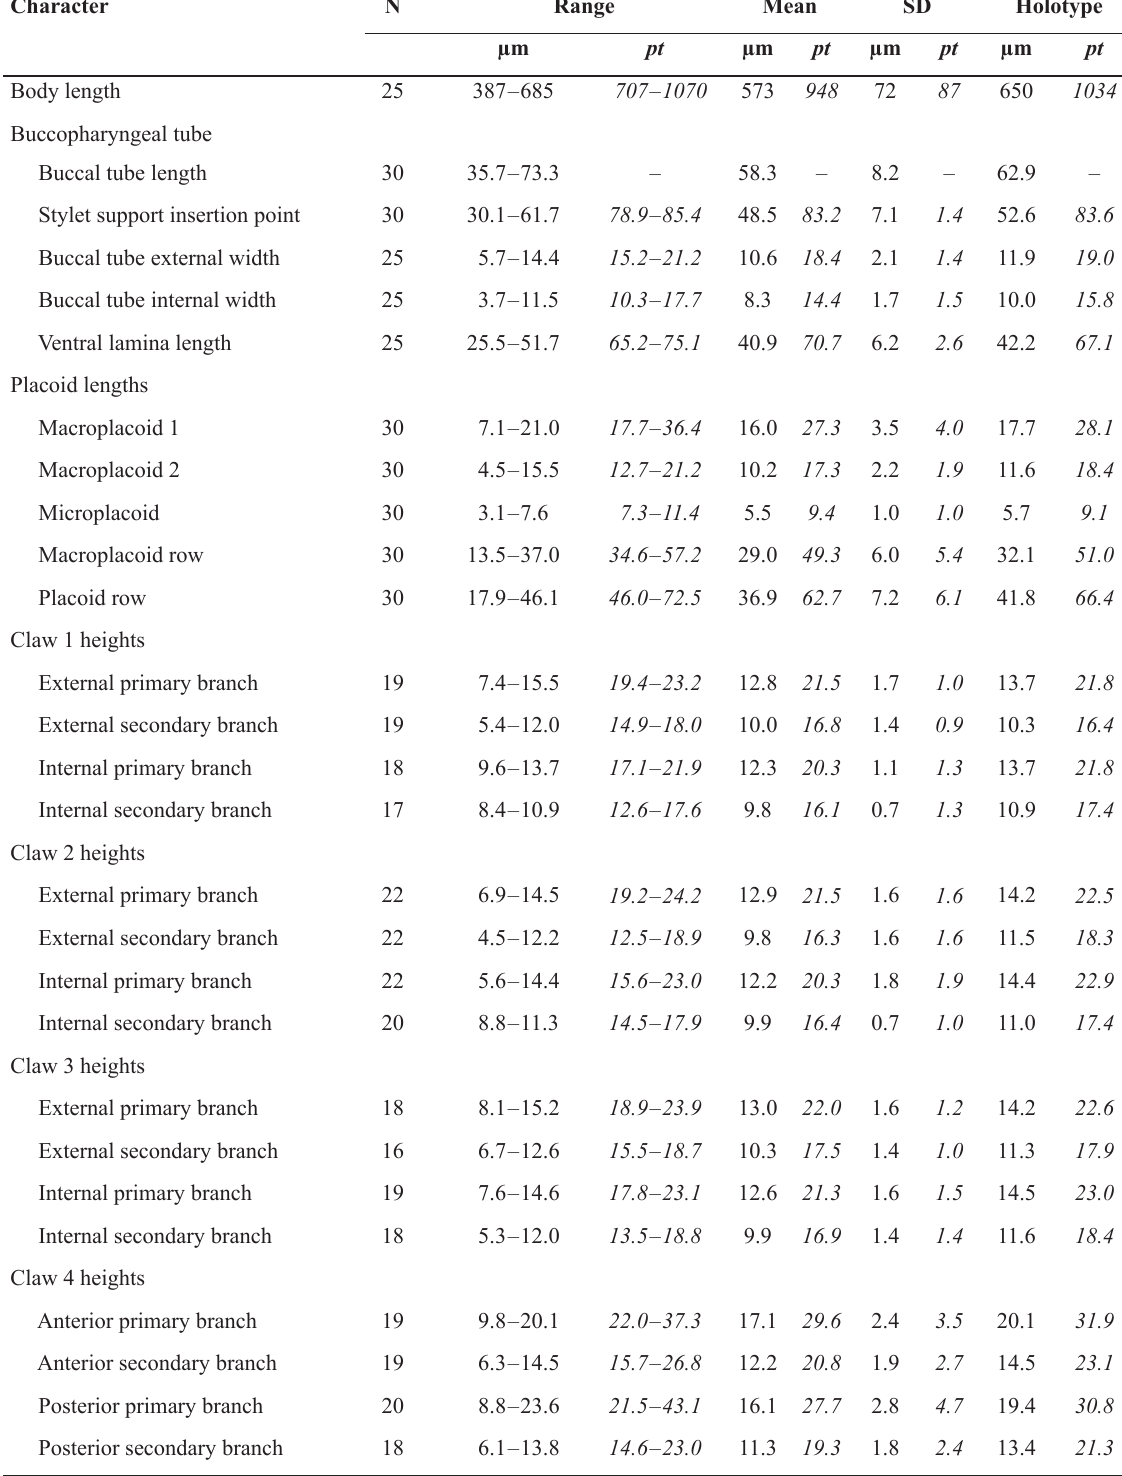
Table 2. Measurements (in μm) of selected morphological structures of the animals of Sisubiotus hakaiensis sp. nov. mounted in Hoyer’s medium. Abbreviations: N = number of eggs/structures measured; Range = the smallest and the largest structure among all measured specimens; SD = standard